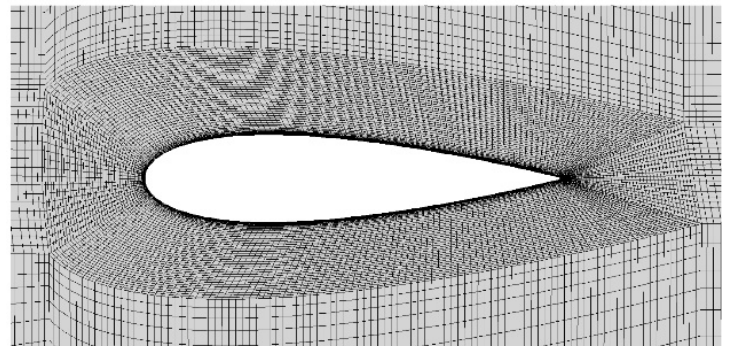
Figure 1. Mesh for NACA0021 (236 points on the surface of the airfoil and 143 points in wall-normal direction).